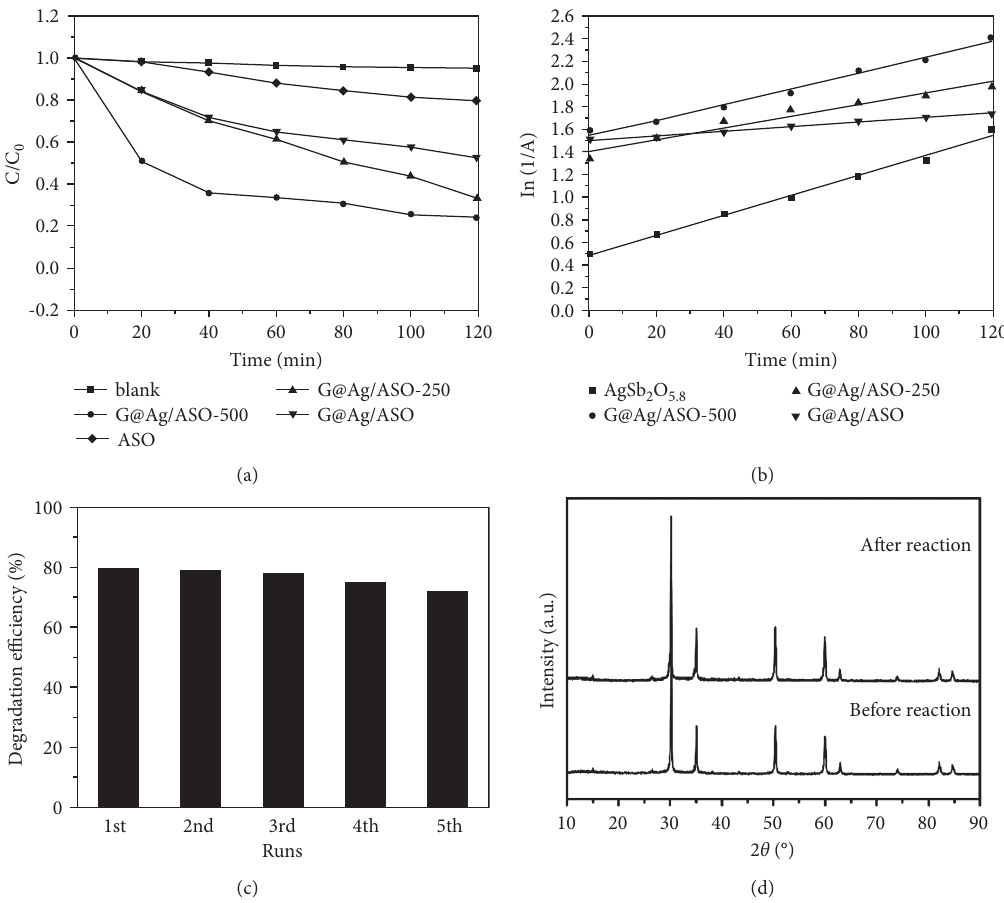
Figure 8: (a) photocatalytic degradation of RhB and (b) linear transform ln (1/A) of the kinetic curves of RhB degradation; (c) five recycling runs of G@Ag/ASO-500 for RhB removal; (d) the XRD patterns of the original and recycled